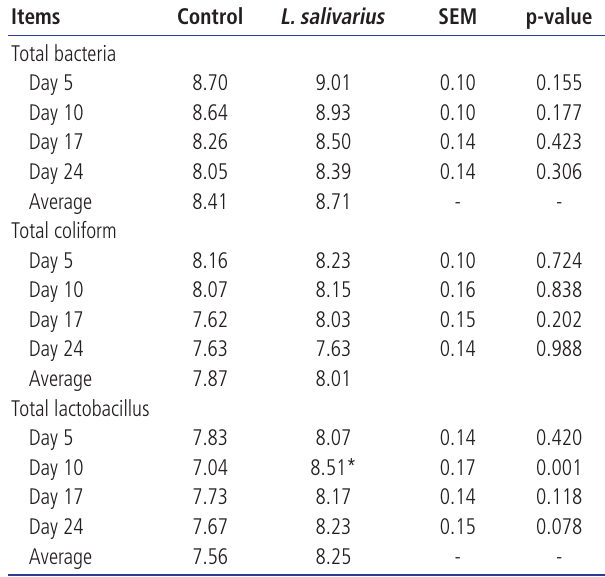
Table 5. Effect of Lactobacillus salivarius on fecal bacterial population of piglets challenged with Escherichia coli F4 (Log10 cfu/mL)